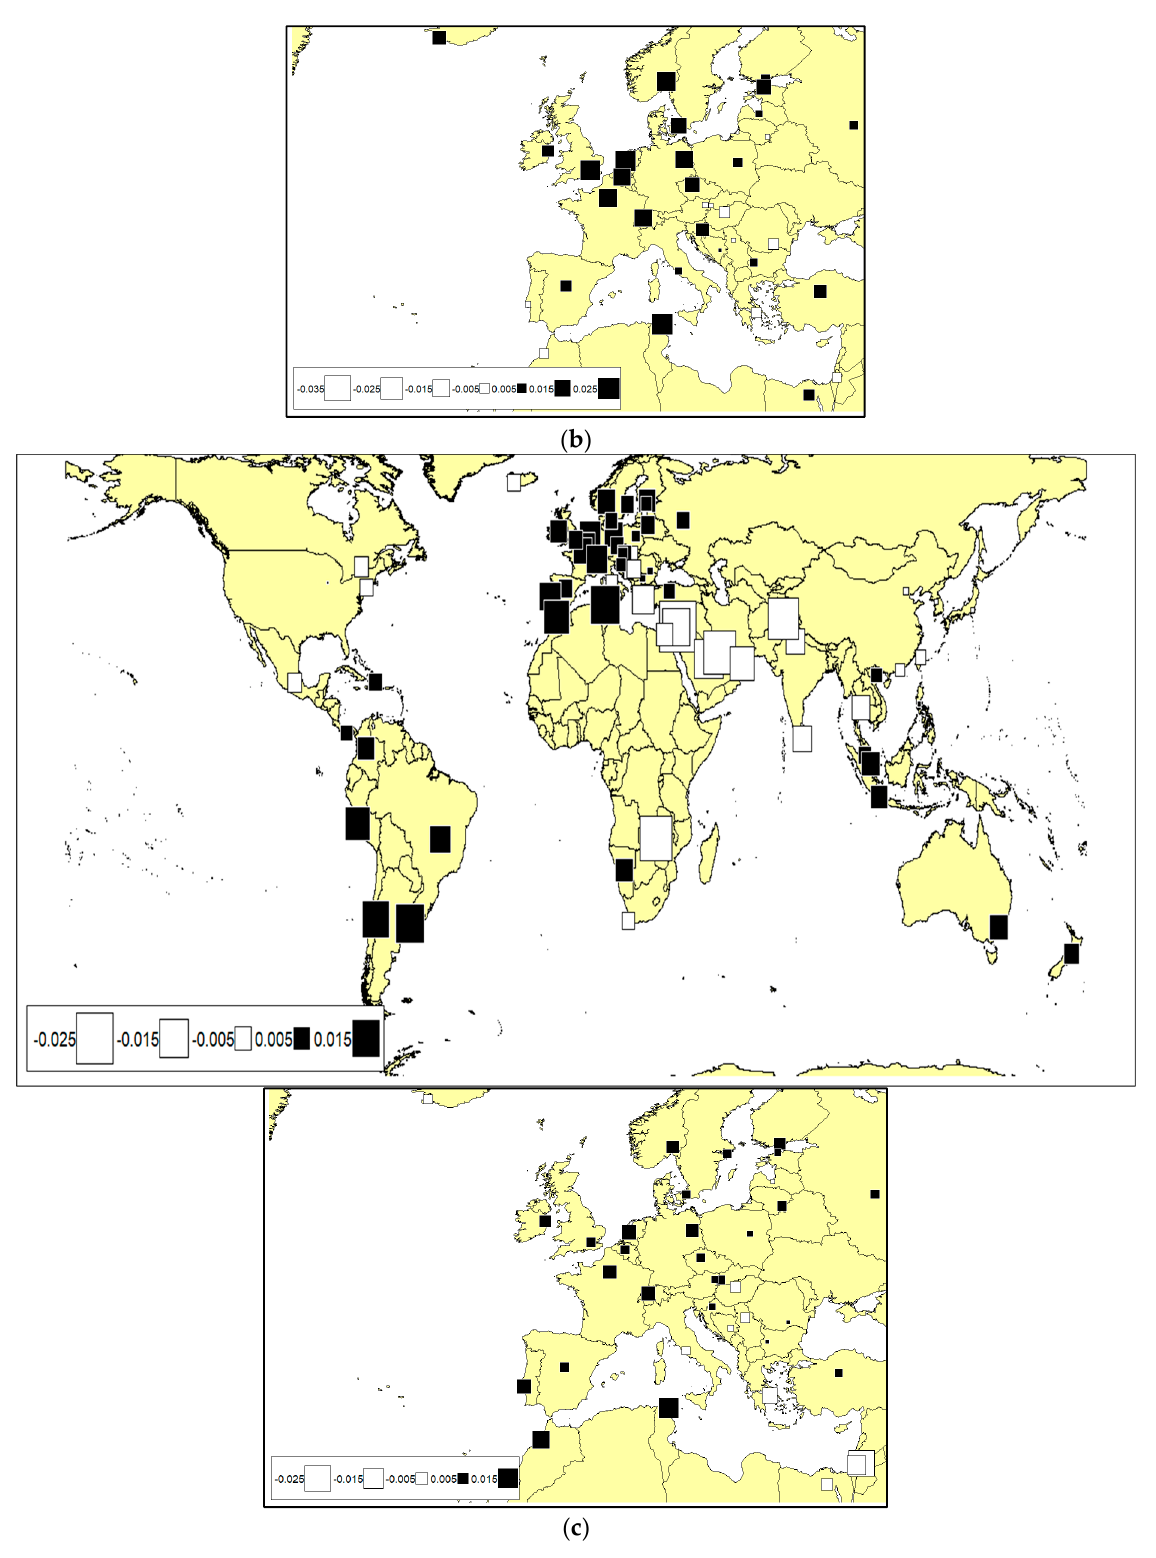
Figure A6. Map of projected second positive PC scores from FASPCA and Gabriel graph-based connection network; the smaller map below each bigger map is the zoom-in of Europe: ( a ) period 1; ( b ) period 2; ( c ) period 3.